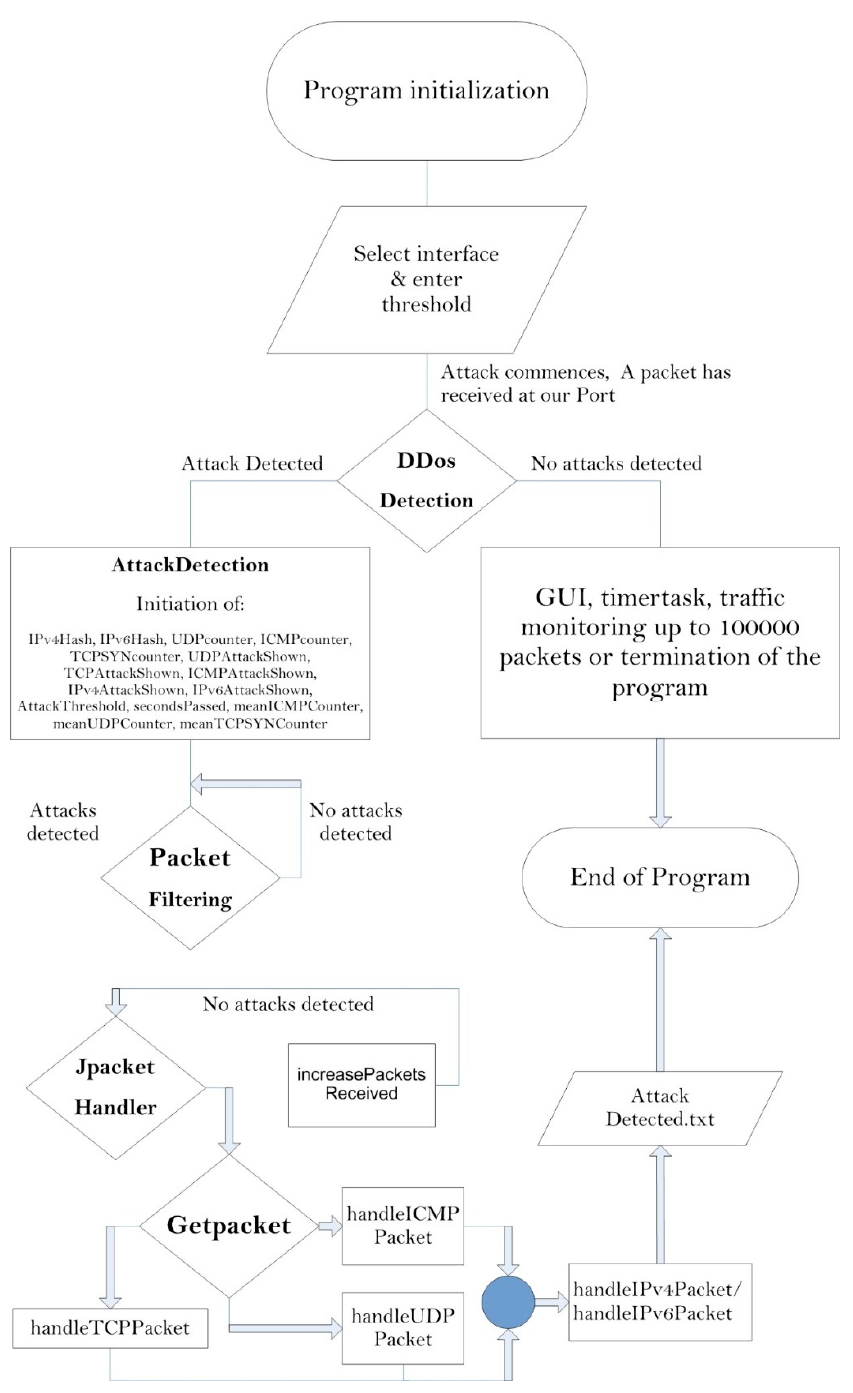
Figure 5. Flow chart of the proposed scheme.